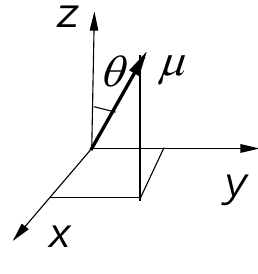
Figure 5. Schematic of dipole angle θ .